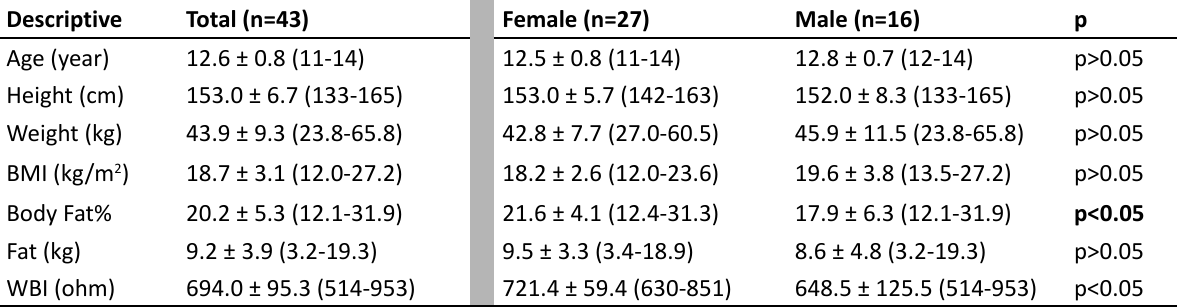
Table 2. Age, height, weight, body mass index (BMI), body fat percentage and fat content, and whole body impedance (WBI) of subjects.